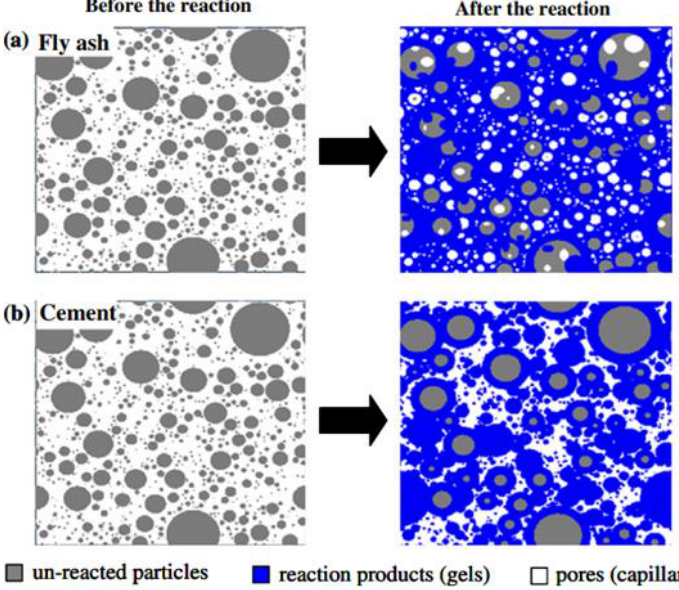
Figure 9. Formation of the microstructure in different systems caused by different silica modulus: ( a ) AAMs activated with a high silica modulus; ( b ) AAMs activated with a low silica modulus or cement paste materials no silica [108].